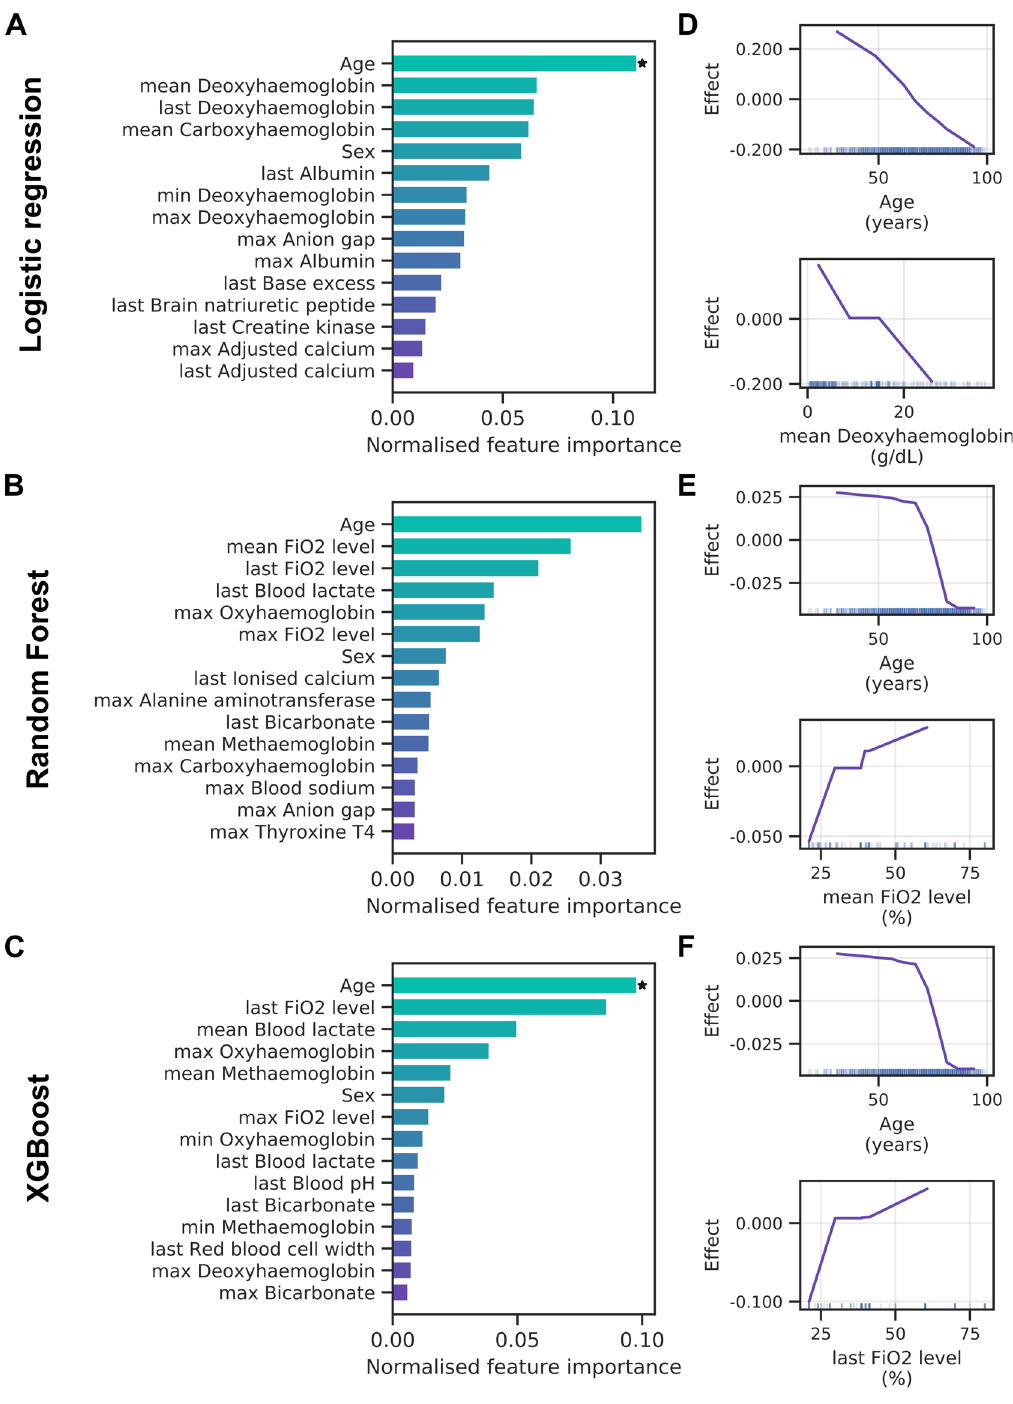
Figure 5. Feature importance for mechanical ventilation. Permutation feature importance for the random forest ( A ), logistic regression ( B ) and XGBoost ( C ) models. Only the top 15 features are shown. Asterisks mark features with importance scores significantly different from zero across three cross-validation folds with t-test p value thresholds of 5% ( *) and 1% (* *). ( D–F ) Accumulated local effects plots for the logistic regression ( D ), random forest ( E ) and XGBoost models ( F ). The top two features according to permutation feature importance are shown for each model. Vertical bars at the bottom indicate feature values observed in the data